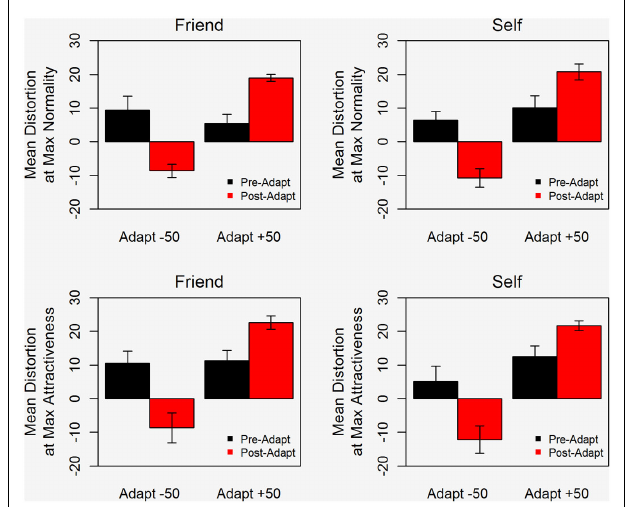
FIGURE 3 | Mean distortion level corresponding to the maximum rating of normality (top) and attractiveness (bottom) for images of Self (right) and Friend (left). Error bars show ± 1 standard error of the